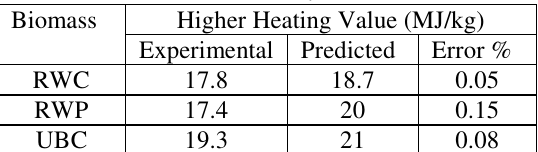
Table 3: Comparison of Measured HHV with Estimates